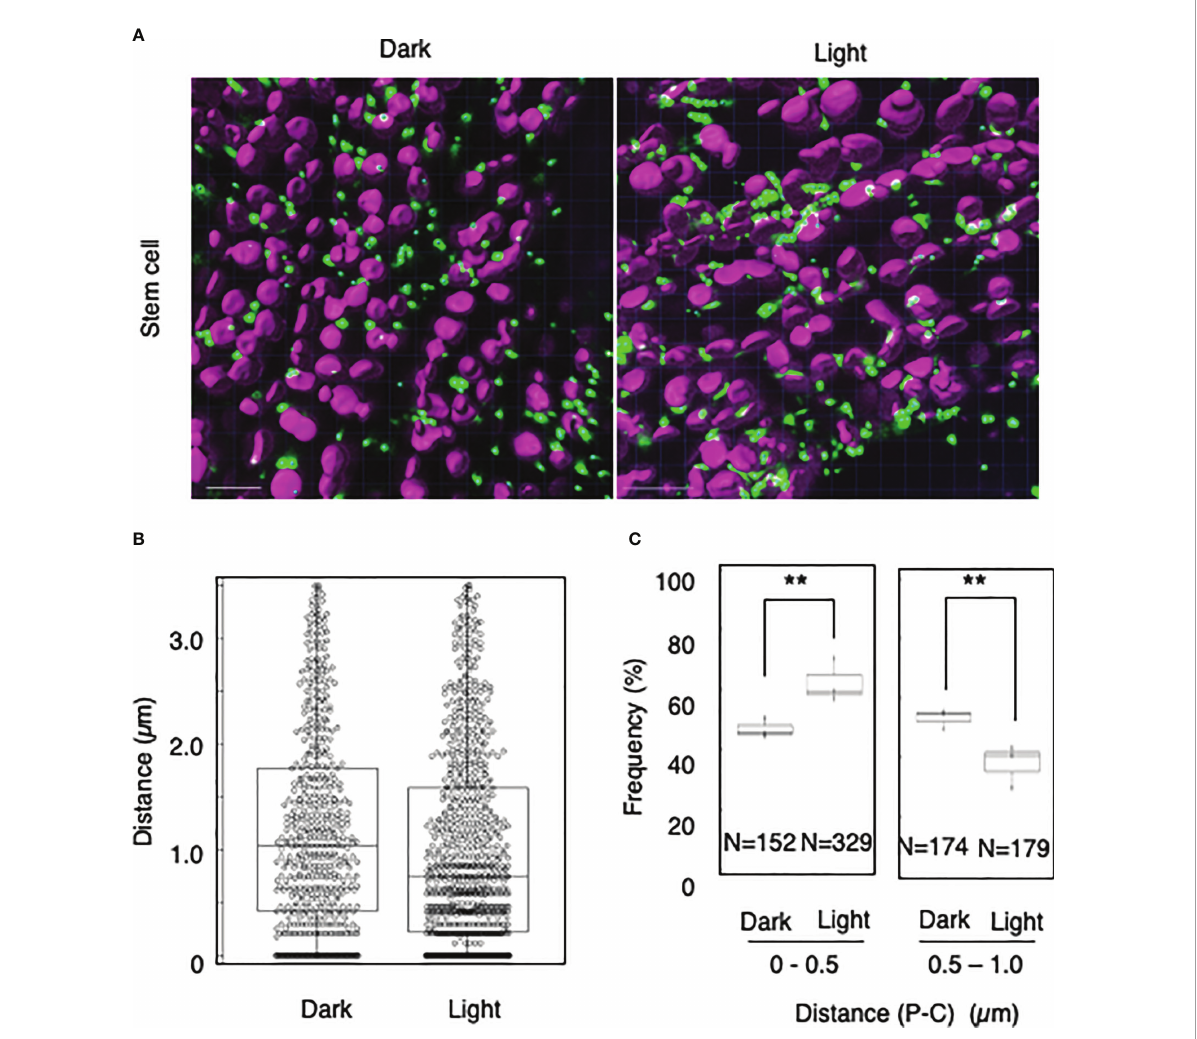
FIGURE 3 Measurement of the distances between chloroplasts and peroxisomes in stem cells. (A) Representative images of chloroplasts (magenta) and peroxisomes (green) in stem cells in the dark (left) and light (right). Bars, 10 µm. (B) Box plots of the distances between peroxisomes and chloroplasts in stem cells in the dark and light from three image areas. The average distance was 1.20 ± 0.94 µm (n = 540) in the dark and 1.01 ± 0.92 (n = 844) in the light. The median distance was 1.04 µm in the dark and 0.75 µm in the light. (C) The frequency of the distances between peroxisomes and chloroplasts in the dark and light. The frequency of distances of 0 – 0.5 µm was 46.9 ± 3.3% in the dark (n = 152) and 62.3 ± 7.2% in the light (n = 329), whereas the frequency of distances of 0.5 – 1.0 µm was 53.5 ± 3.3% in the dark (n = 174) and 37.7 ± 7.2% in the light (n = 179) in (B) . ** P < 0.01, Student ’ s t